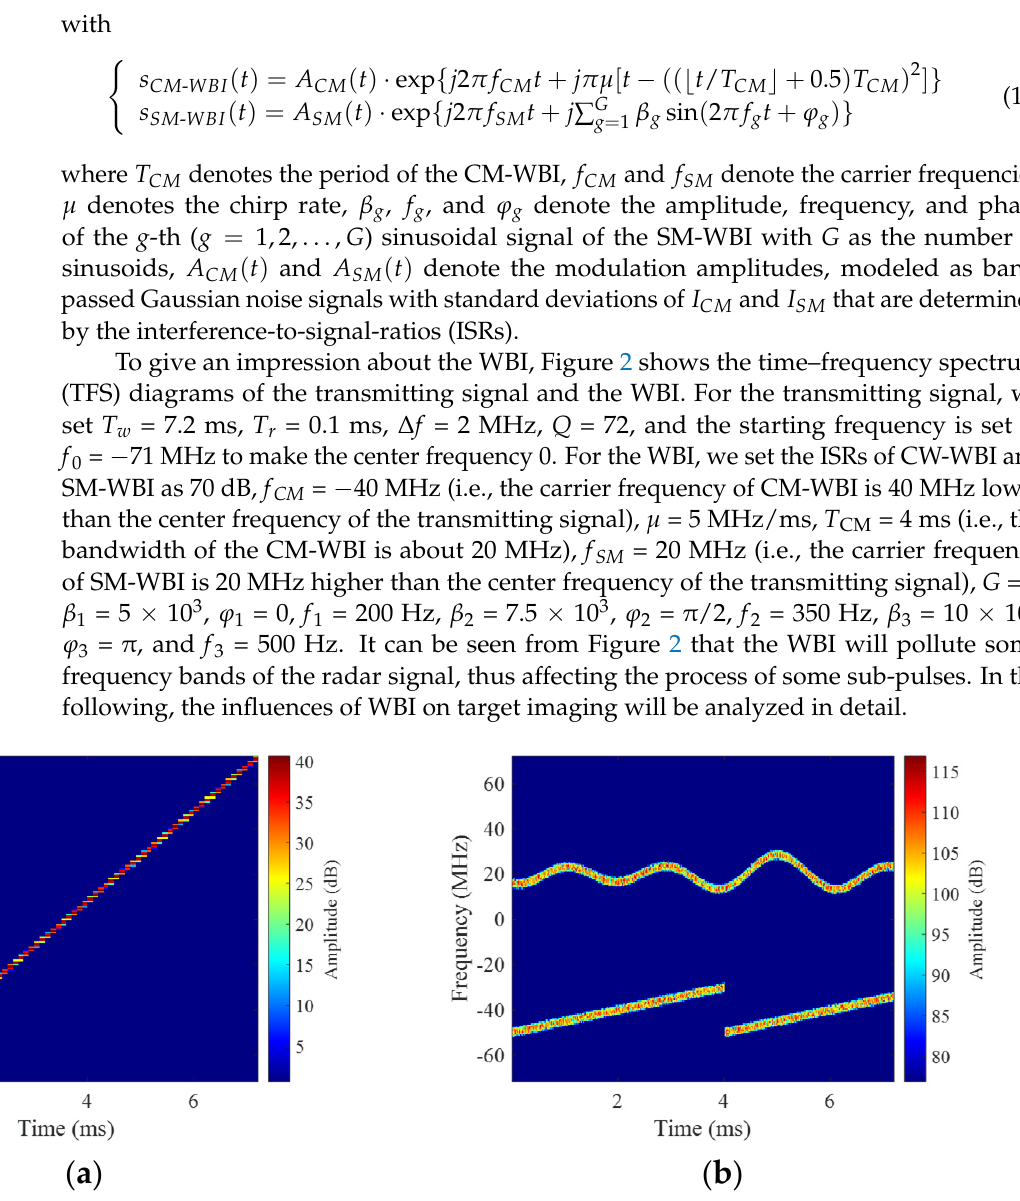
Figure 2. TFS diagrams of ( a ) the transmitting signal and ( b ) the considered WBI with ISR = 70 dB. For the frequency-stepped narrow-band orthogonal signal used in this paper, its wide bandwidth is obtained by changing the carrier frequencies of the radar signal in different sub-pulses. For each sub-pulse, its instantaneous bandwidth is limited. Hence, the WBI will not pollute the signal frequency band completely in each measurement. In other words, as given in (3), the received signal will be down-converted and then be low-pass filtered, resulting in the fragmentized WBI segments that only affect partial sub-pulses that work in the WBI occupied bands, as illustrated in Figure